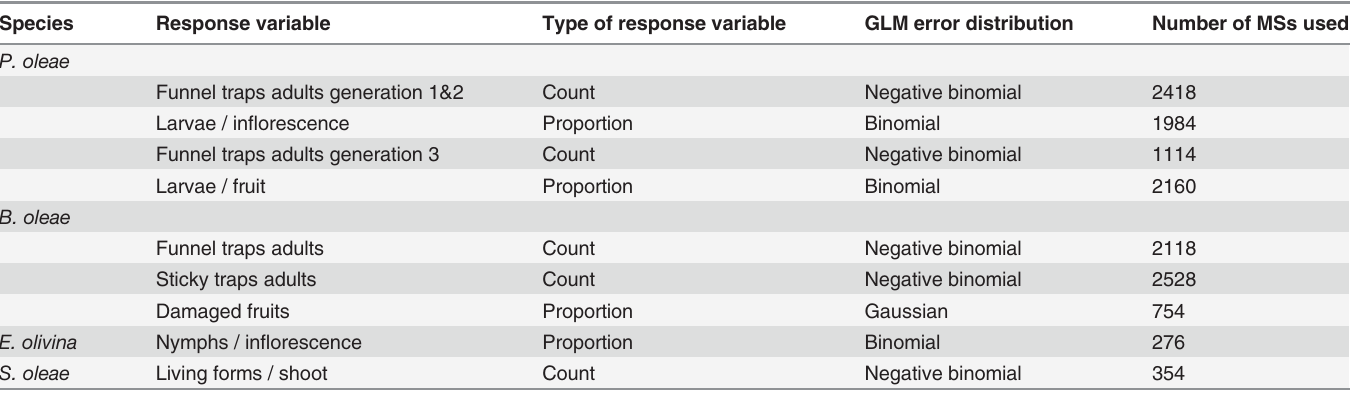
Table 1. Response variables used for each of the four species analysed in this study, family error used in the generalized linear mixed models, and number of observations (i.e. number of monitoring stations) available for each response variable for all the years.